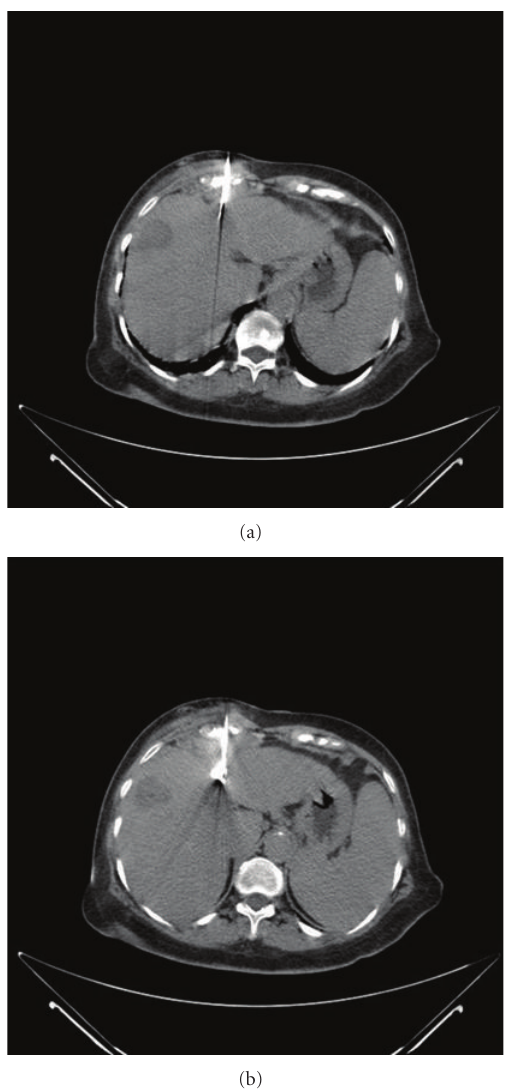
Figure 2: The front path just over the lesion was chosen. The tip of the electrode was positioned in the correct position and it was deployed